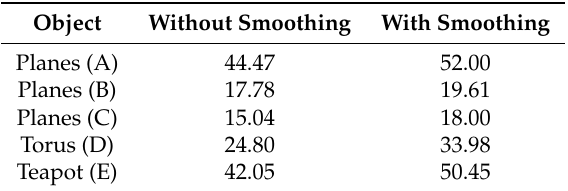
Figure 12. Three experimental images: ( a – c ) three planes, ( d – f ) torus, and ( g – i ) teapot. ( a , d , g ) Color images. Each image is a 3D CG object. ( b , e , h ) Depth maps. ( c , f , i ) Depth maps with eliminated areas. Table 1. PSNR values (dB) of inpainted depth maps obtained using the proposed method. (A)–(E) indicate the eliminated areas in Figure 12.